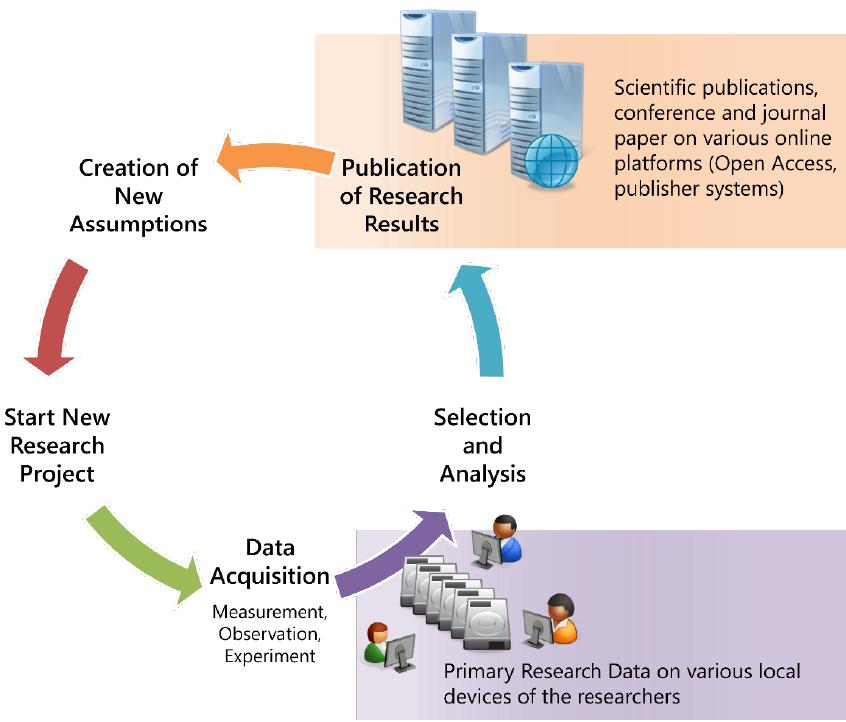
Figure 1. Traditional Lifecycle of Research Data.